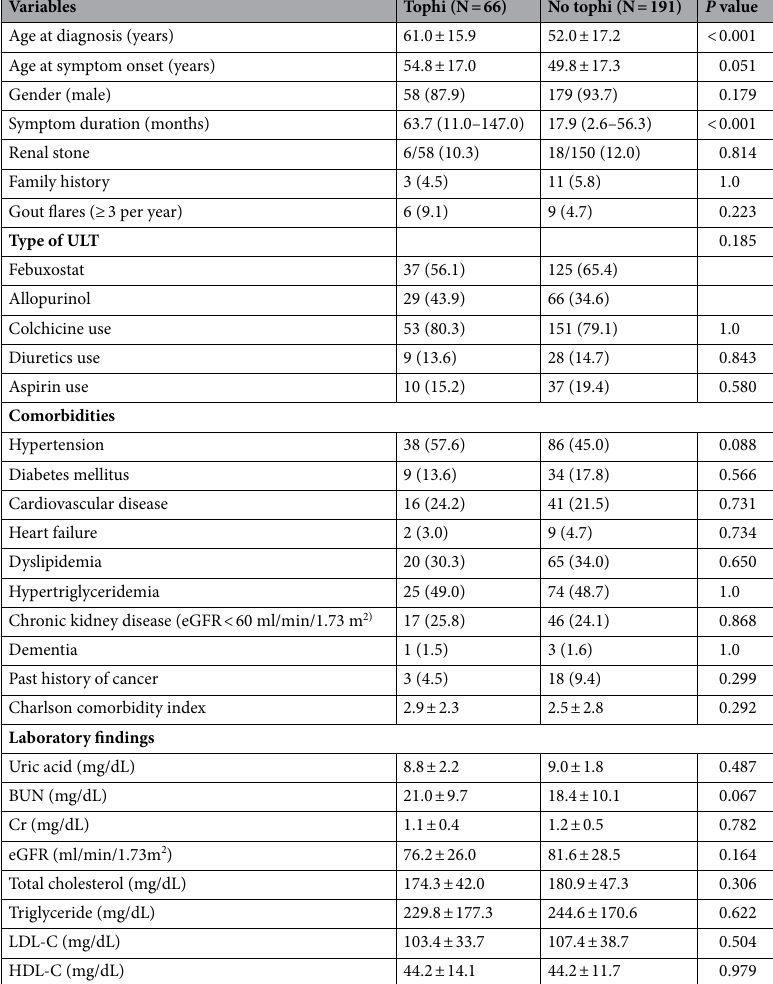
Table 1. Baseline characteristics according to the presence of tophi. Results are expressed as the mean ± SD, as the median (interquartile range, IQR), or as number (%). ULT urate lowering therapy, BUN blood urea nitrogen, Cr creatinine, eGFR estimated glomerular filtration rate, LDL-C low-density lipoprotein cholesterol, HDL-C high-density lipoprotein